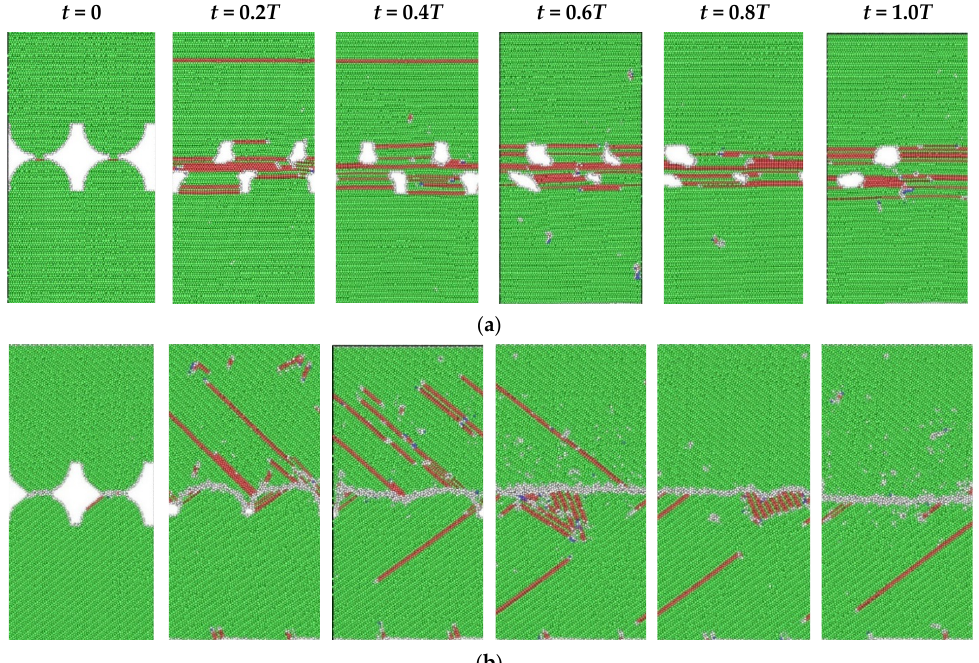
Figure 2. Snapshots of the atomic structure of Model I under the applied clamping pressure of 270 MPa ( a ) and Model II under the pressure of 67 MPa ( b ) after the equilibration at T = 300 K ( t = 0) and at different time moments of t = 0.2 T , 0.4 T , 0.6 T , 0.8 T , and 1.0 T . Atoms are colored according to their local crystalline structure (see description in the text). The whole computational cell is presented in each case.